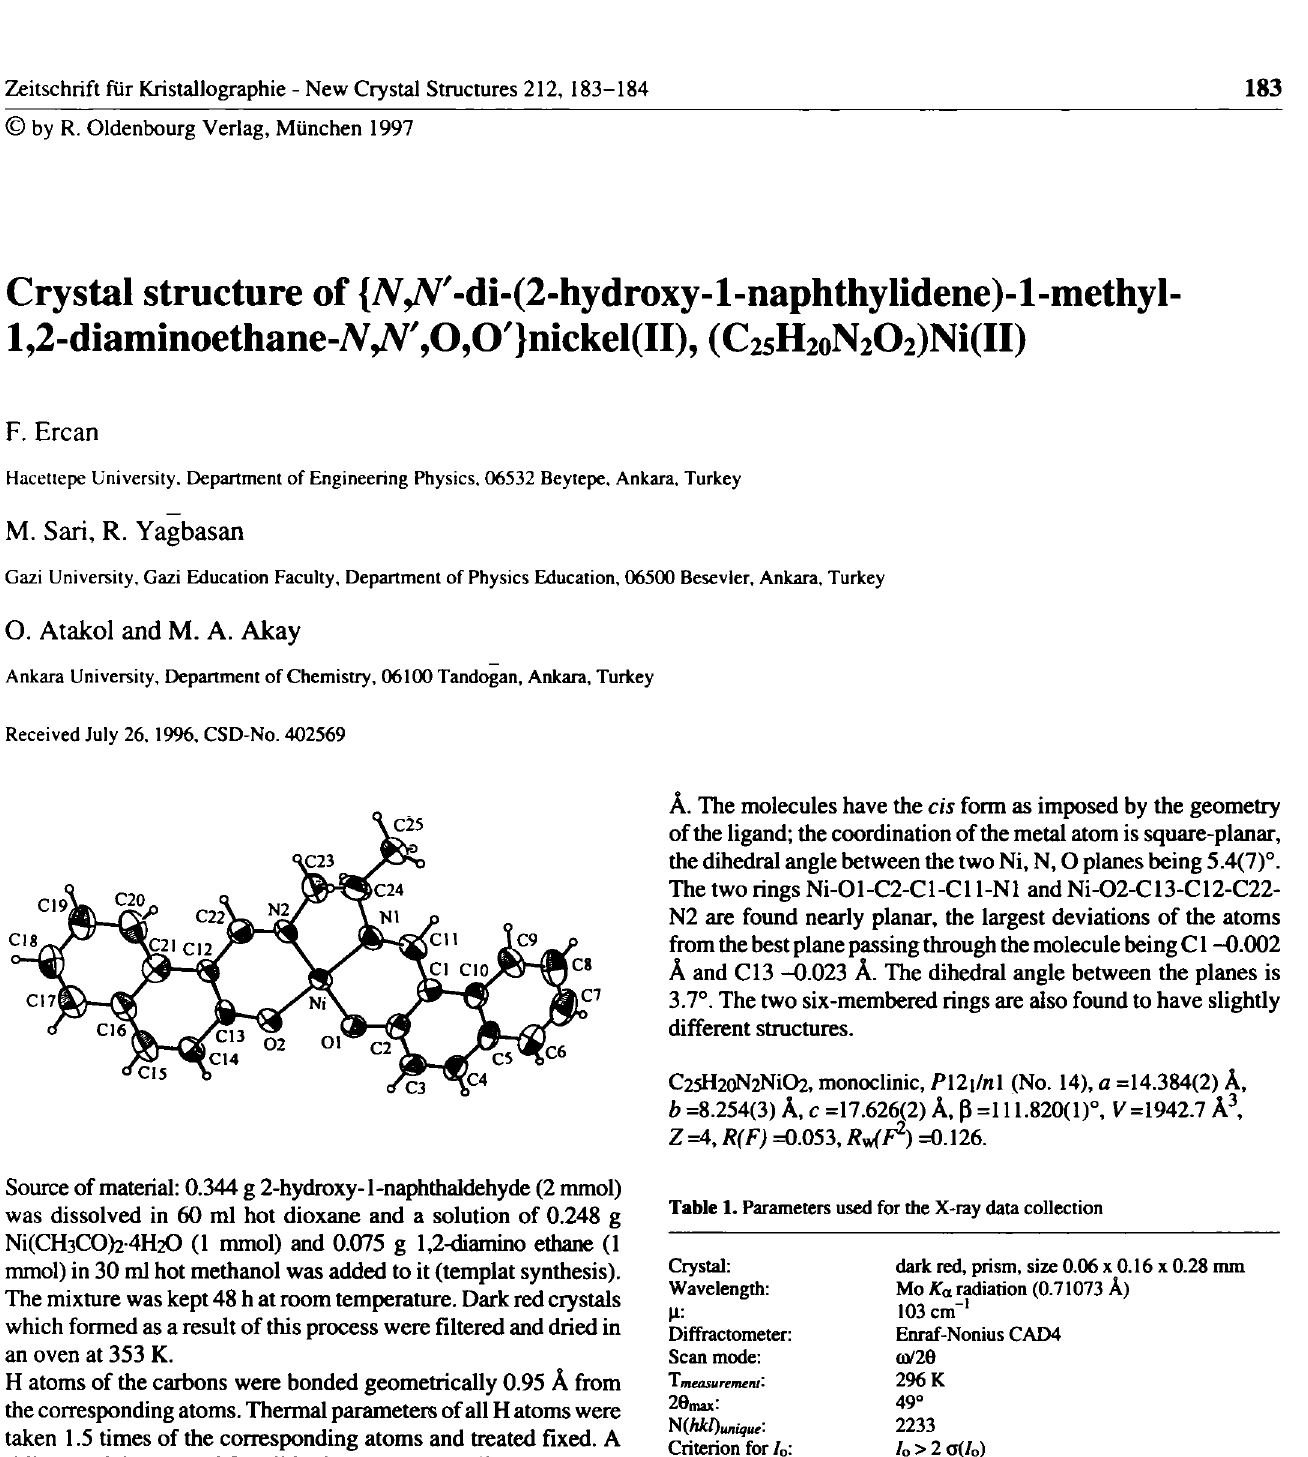
Table 2. Final atomic coordinates and displacement parameters (in Â 2